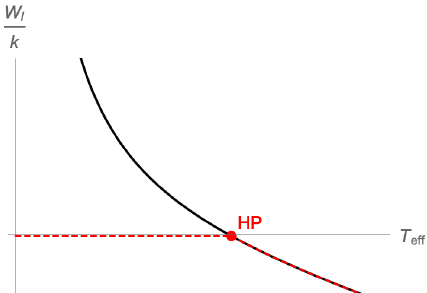
Figure 1 . Index-inspired free energy (3.36) as a function of effective temperature T eff = − ˜ µ − 1 , not drawn to scale. The red dashed line represents the thermal gas phase for lower temperature, and the large black hole phase for higher temperature. The red dot represents the Hawking-Page transition point between the